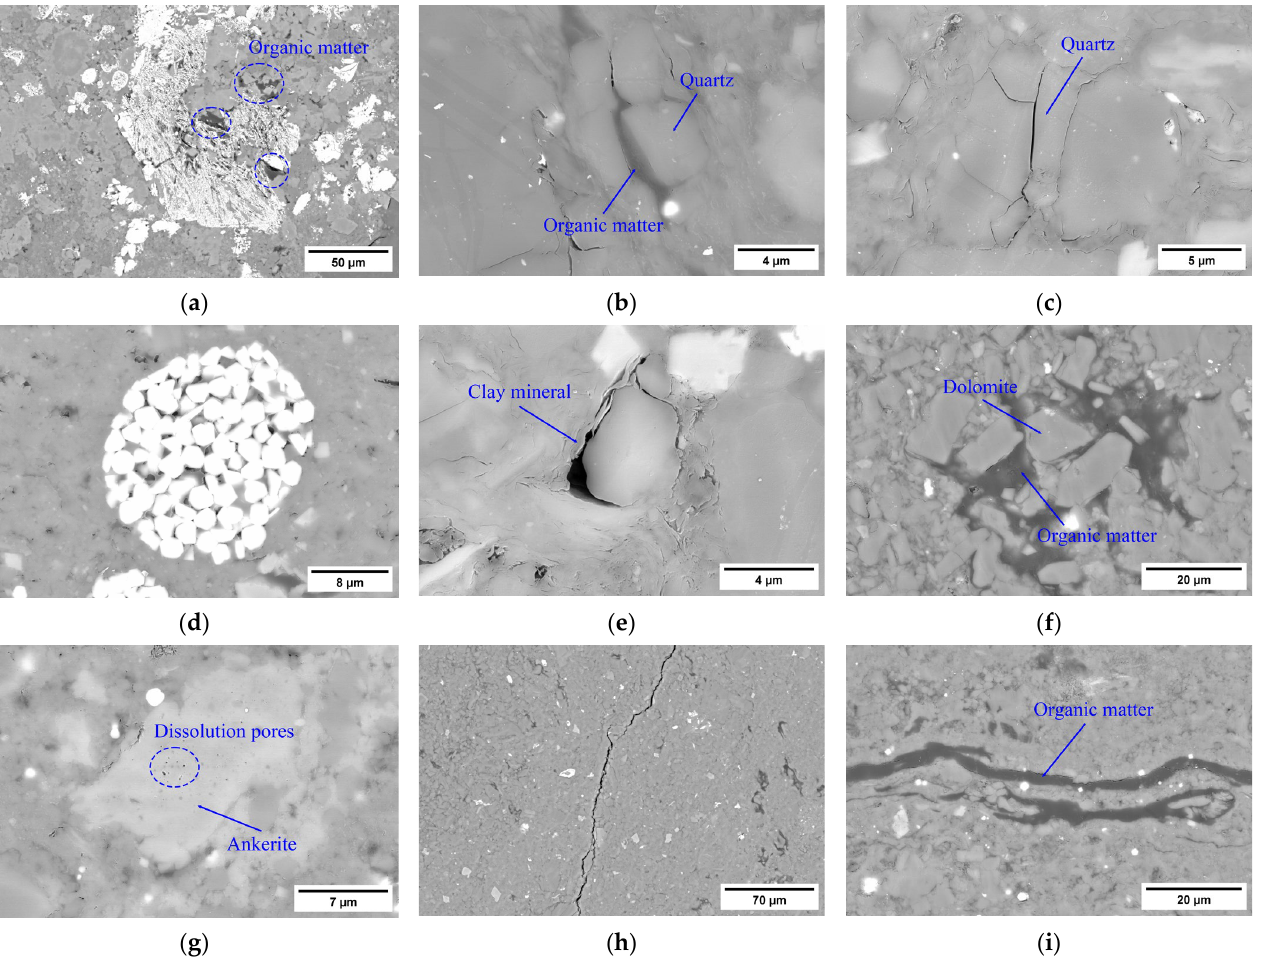
Figure 4. Pore types of Sha-4 shale samples. ( a ) The mineral grains are filled with a large amount of organic matter; ( b ) Intergranular pore filled with organic matter; ( c ) Intergranular pore of quartz; ( d ) Inter-crystalline pores of Pyrite; ( e ) Inter-crystalline pores of clay minerals; ( f ) Inter-crystalline pores of dolomite; ( g ) Dissolution pores of ankerite; ( h ) Microstructural fracture; ( i ) Bedding joint, filled with organic matter.